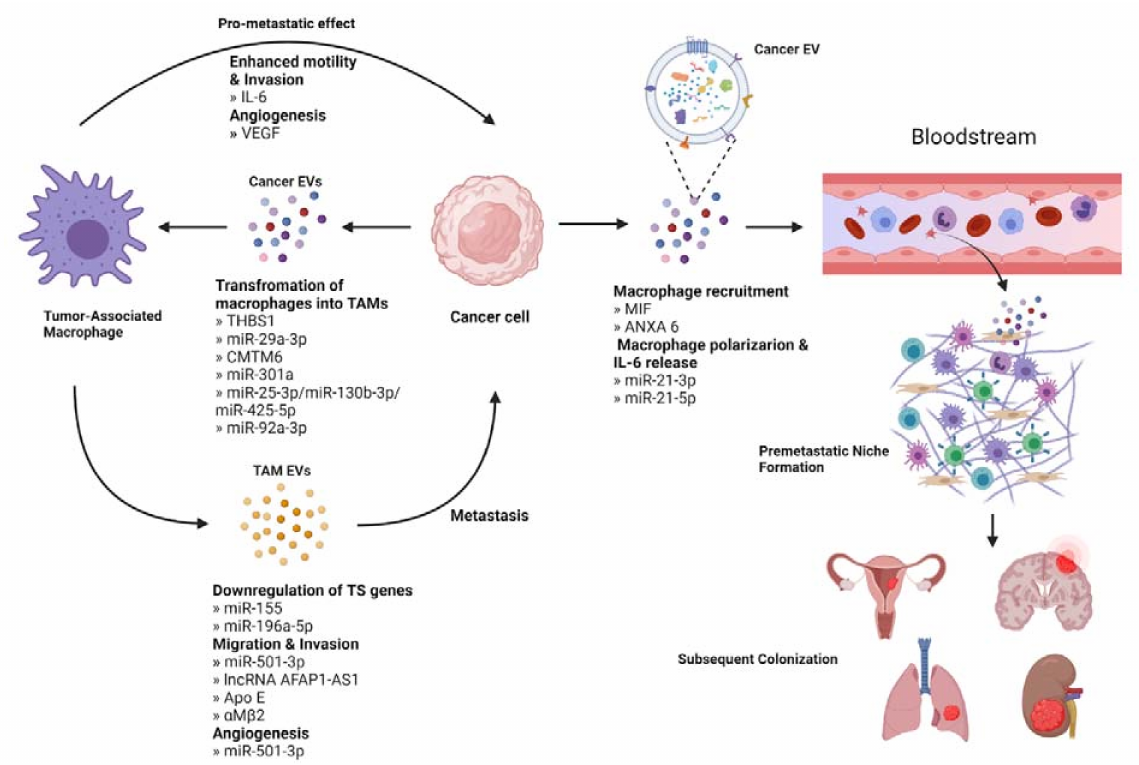
Figure 4. Interaction between cancer cells and tumor associated macrophage (TAMs). Cancer derived EVs deliver factors like miRNAs that promote the transformation of macrophages into TAMs. TAMs can stimulate metastasis directly or through EV-mediated downregulation of tumor suppressor genes, increased migration, and invasion potential, and supporting angiogenesis. Cancer cells also release EVs that act in an endocrine manner to stimulate the recruitment of macrophages in a secondary site. These macrophages then undergo polarization to support the establishment of the pre-metastatic niche, aid to evade the immune surveillance, and contribute to subsequent